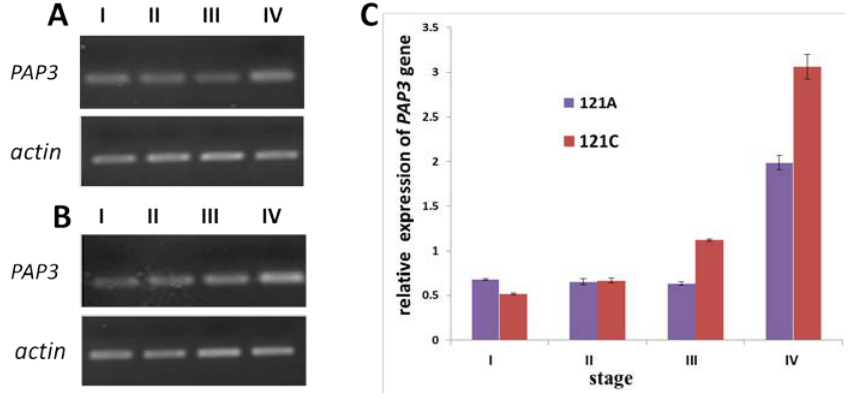
Figure 3. PAP3 expression measured by semi-quantitative RT-PCR and